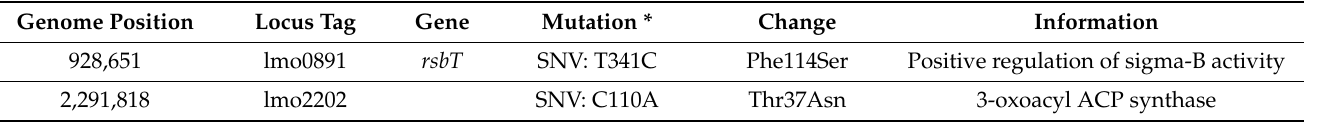
Table 3. Mutations of LmSCar (evolved by exposure to prolonged sublethal doses of carvacrol) in comparison with LmWT, verified by Sanger sequencing. SNV: single nucleotide variation. Genome Position Locus Tag Gene Mutation * Change Information 928,651